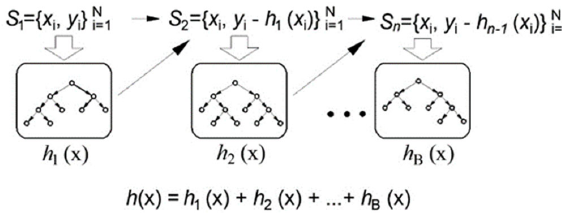
Figure 4. Creation of boosted trees ensemble [2].